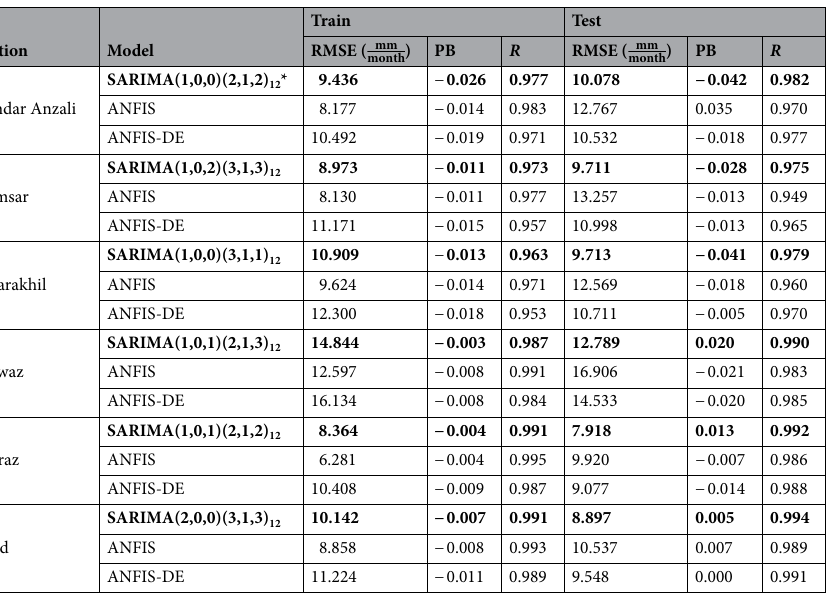
Table 4. Evaluating the models’ predictions by evaluation criteria. *Bold rows specify the best-fitted model in each